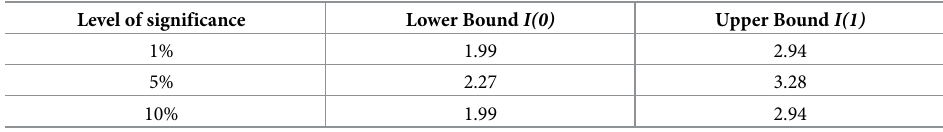
Table 6. The critical values of the ARDL bounds